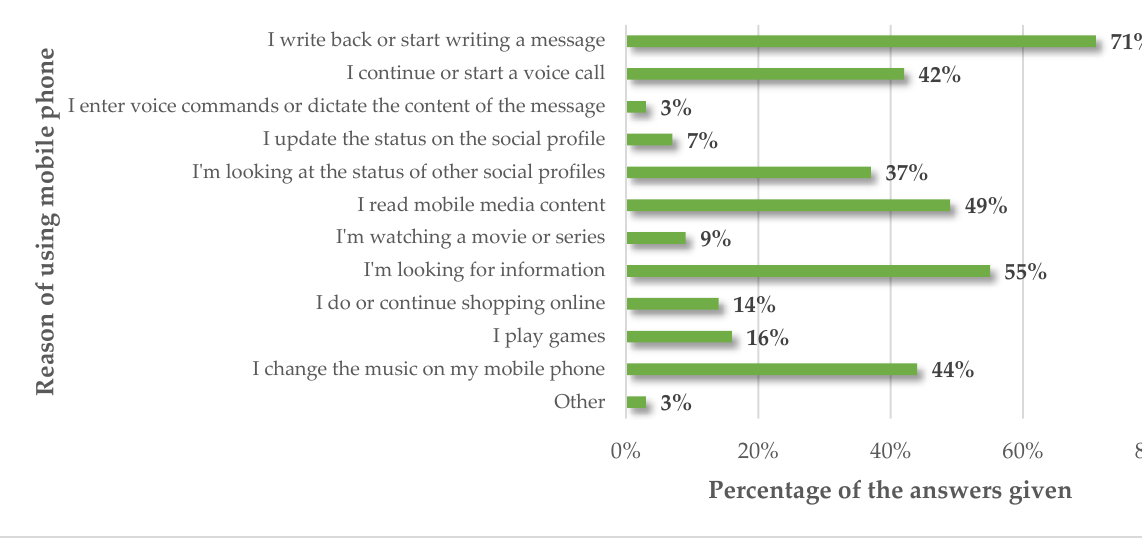
Figure 2. Typical purposes of using the telephone as a passenger while traveling. The indicated reasons for using the telephone during the journey as a passenger are presented in Figure 2. Most people believe that they use the telephone to reply/start texting (71.12%). In turn, more than half of the respondents “simply” look for information (55.21%) and read the content of mobile media (49.31%). Almost half of the people said that they change their music (43.61%), continue/start a voice conversation (42.24%), and look at the status of other people on social networks (37.13%). About 15% of respondents say that they use a phone to play games and continue shopping online. The smallest percentage of respondents chose to update their status on a social networking site (7.47%), watch a movie/series (8.64%), and enter/continue voice commands (3.34%). Moreover, 1.18% of the respondents replied other, of which the use of navigation accounted for almost 90% of these responses. The rest of the respondents use the telephone to check the time.